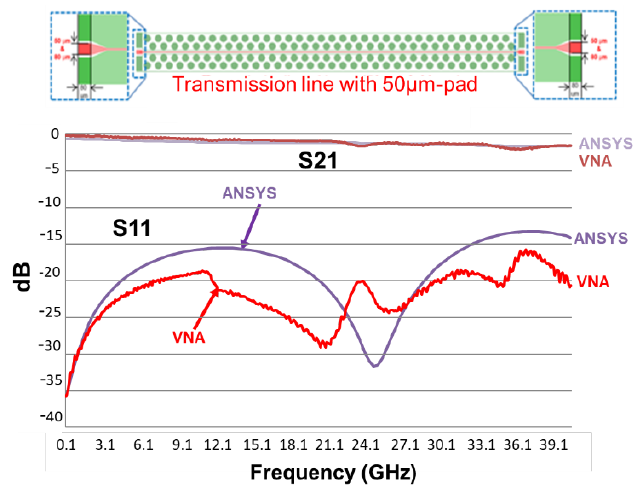
Figure 18. The VNA measurement results of test vehicle (50 μm pad) and correlation with ANSYS results.